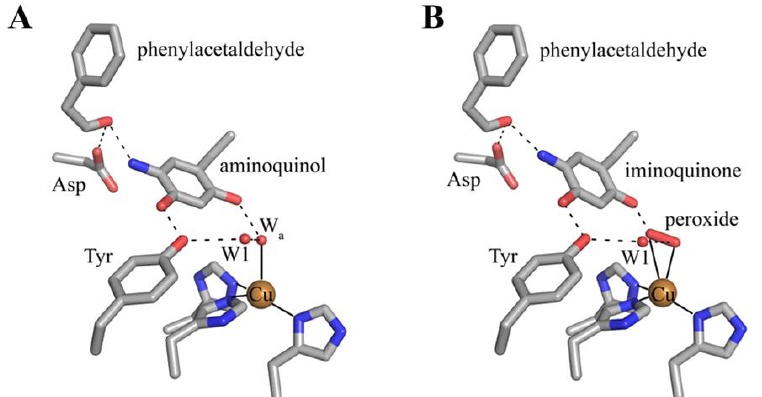
half-reaction. ( A ) Substrate reduced ECAO containing the aminoquinol (PDB code 1d6u) [88]. ( B ) ECAO containing the iminoquinone (PDB code 1d6z) [88]. Residues are drawn in stick and colored by atom type (carbon, grey). Copper ions are drawn as gold spheres, and water molecules as small red spheres. Hydrogen bonding interactions are indicated by dashed lines, and metal-ligand interactions are indicated by solid